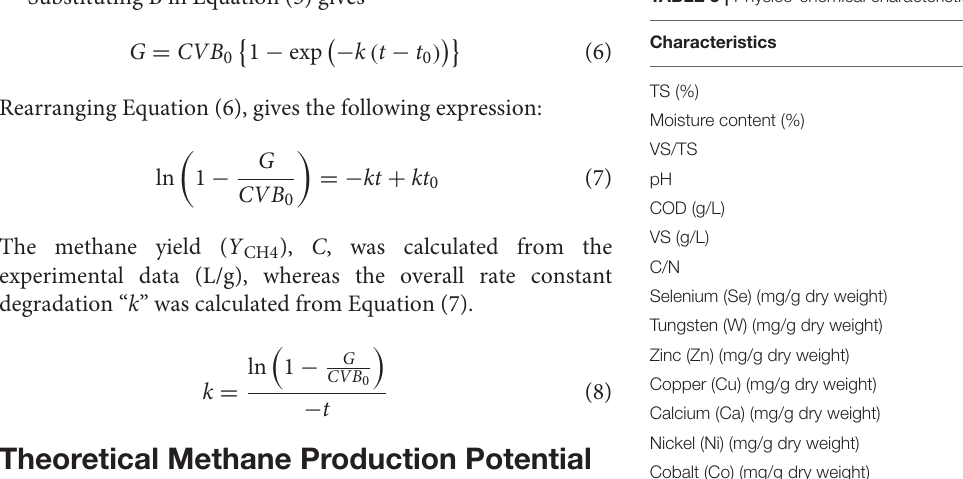
TABLE 3 | Physico-chemical characteristics of the fruit waste ( n =